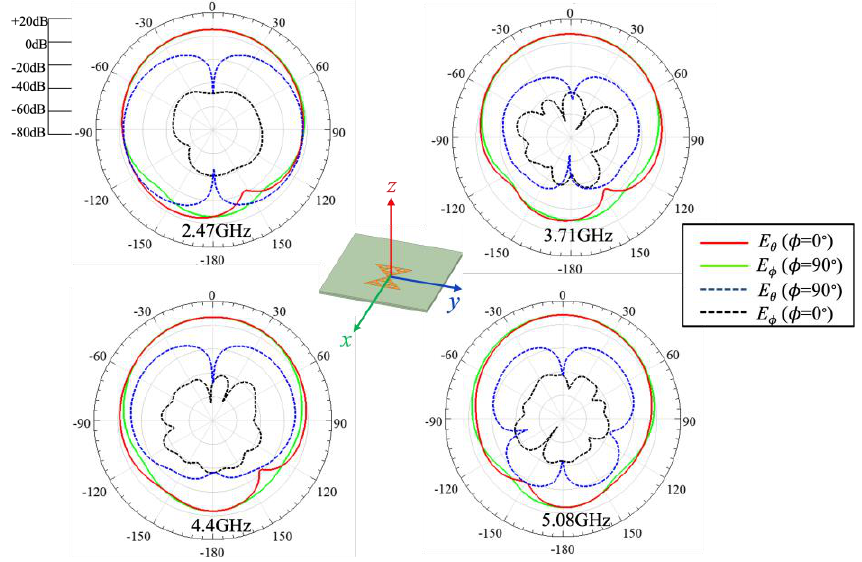
Figure 7. Radiation patterns of the element antennas. Upper left: bow tie fractal patch; upper right: fat bow tie fractal patch; lower left: bow tie patch; lower right: square patch.